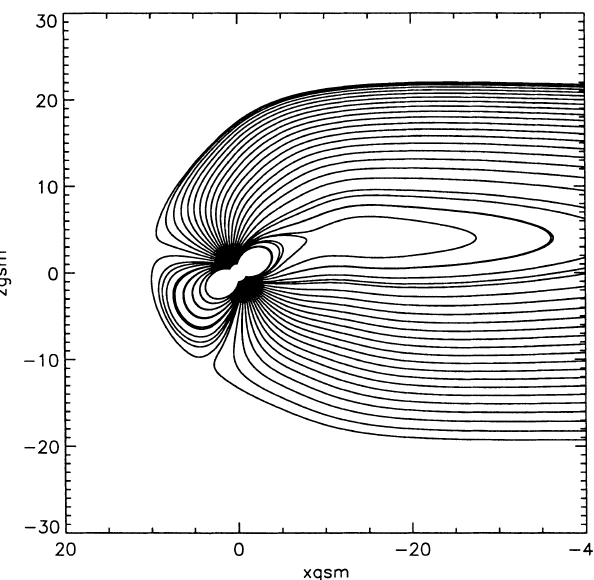
Fig. 9. Same as Fig. 6 but for Kp = 5. The field lines are more compressed. The diameter of the tail is around 40 Re and the subsolar point is located at